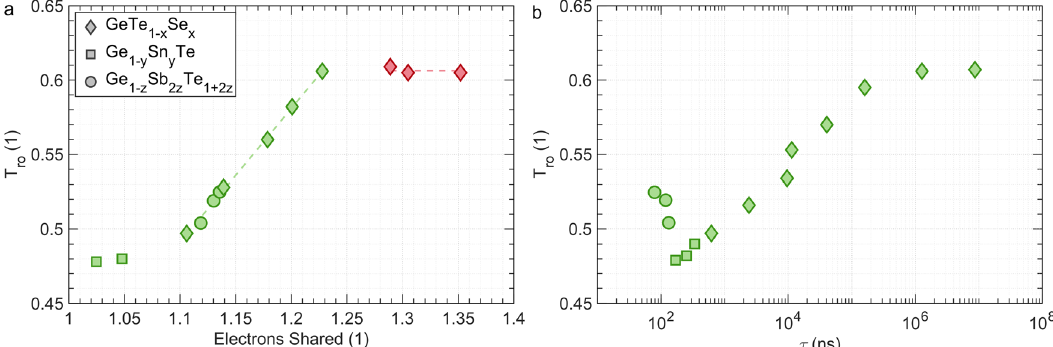
Fig. 3 Glass transition. a Dependence of the reduced onset temperature T ro for glass formation upon ES (for the crystalline phase). T ro was measured at a heating rate of 60,000 K/min. Replacing Te in GeTe by Se leads to a signi fi cant increase in glass-forming ability as characterized by T ro . b Correlation between the minimum time of crystallization τ and T ro . Ultrafast crystallization (low values of τ ) is accompanied by low glass stability (small values of T ro ). Interestingly, compounds on the pseudo-binary line between GeTe and Sb 2 Te 3 , such as Ge 2 Sb 2 Te 5 are characterized by ultrafast crystallization, but slightly improved stability of the glassy state. T ro data are extrapolated from powder samples (see